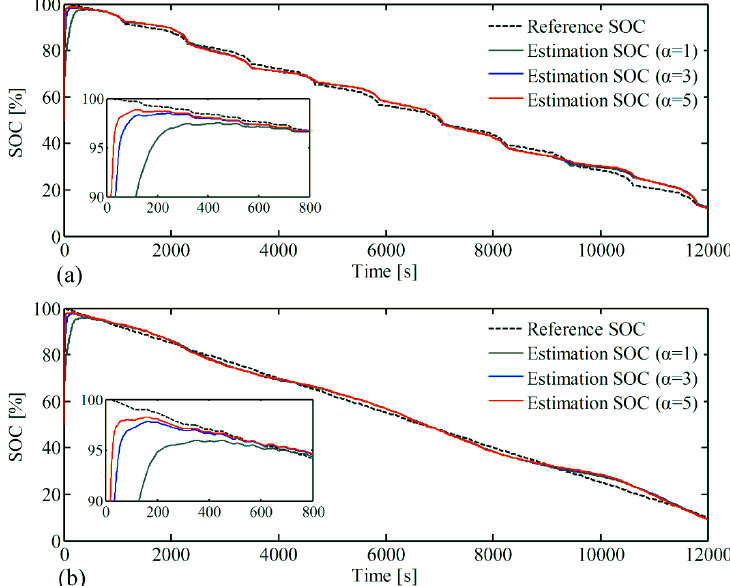
Figure 9. Convergence rate of AGNO with different scale factors: ( a ) NEDC test; and ( b ) FUDS